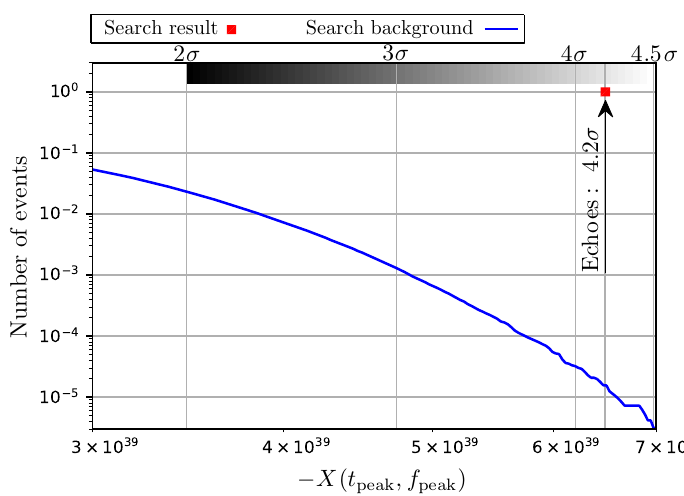
Figure 26. Average number of background peaks higher than a particular -X(t,f) within a frequency-intervals of 63–92 Hz and time-intervals of 1 Section the observed X ( t peak , f peak ) peak at 1.0 s after the merger is − markedbyredsquare. Thehorizontalbarshowstherelationbetween X ( t , f )